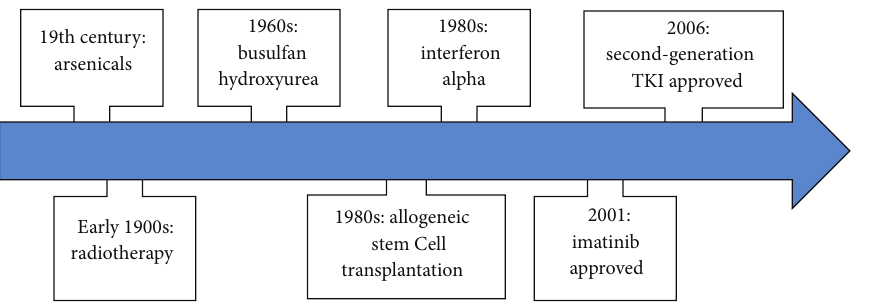
Figure 1: Timeline of CML treatment.